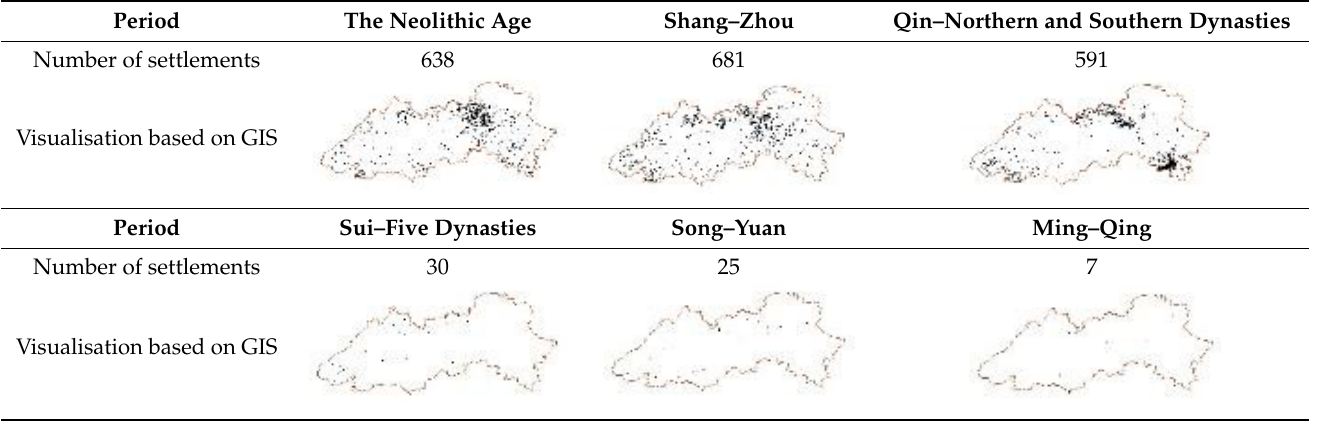
Table 1. Number and visualisation of ancient settlements in each period.